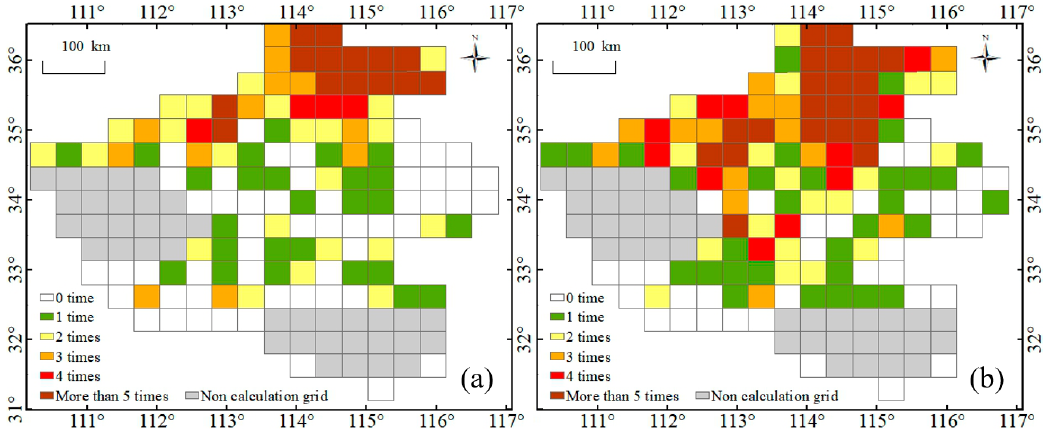
Figure 7. Irrigation frequency maps at a threshold of 0.6 for (a) 2016 and (b) 2017.